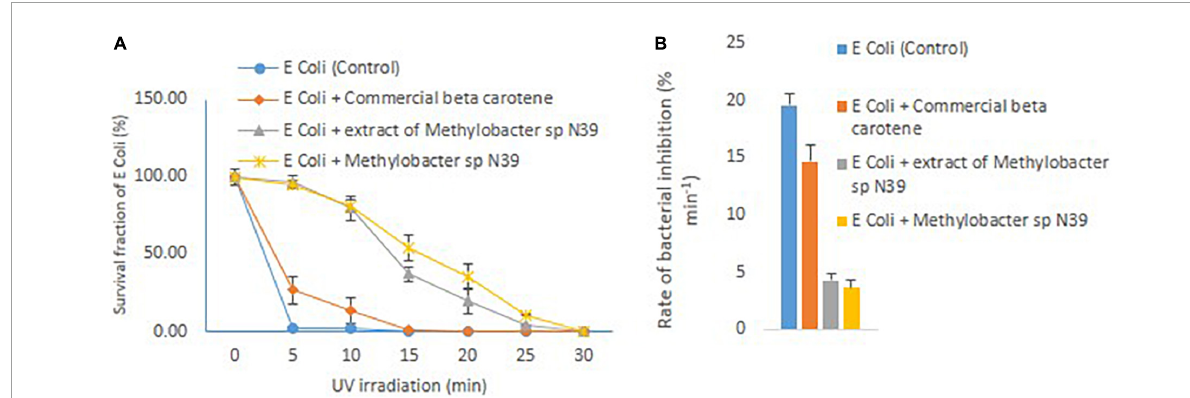
FIGURE5 Effect of Methylobacter sp N39 on extending UV resistance to E. coli bacteria. Cells of E. coli were multiplied in LB media and prepared for different treatments and UV irradiation. The treatments were (1) E. coli suspension (control), (2) E. coli + commercial beta-carotene at 10 µ g ml − 1 , (3) E. coli + extracts of Methylobacter sp N39 extract containing 10 µ g beta-carotene ml − 1 , and (4) E. coli + Methylobacter sp N39. Cell suspensions were spread plated on LB plates and UV irradiated for 0, 5, 10, 15, 20, 25, and 30 min. Colonies were counted after incubation. Left panel (A) represents survival fraction (%) of E. coli in response to UV irradiation. X -axis represents irradiation time in minutes, and Y -axis represents the survival fraction. Right panel (B) represents the inhibition rate of E. coli in response to UV irradiation. Rate of inhibition is determined from the slope of survival fraction vs irradiation time. Each value represents arithmetic mean ± standard deviation as error bar of three replicated